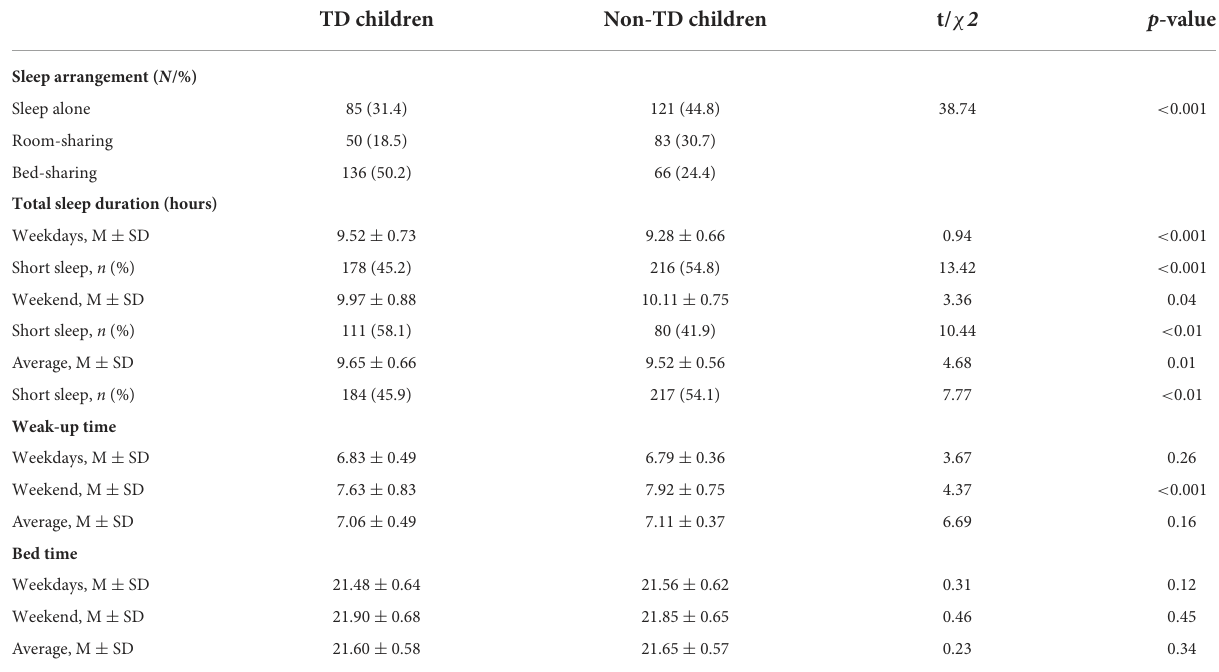
TABLE 2 Sleep arrangement and sleep patterns in children with and without